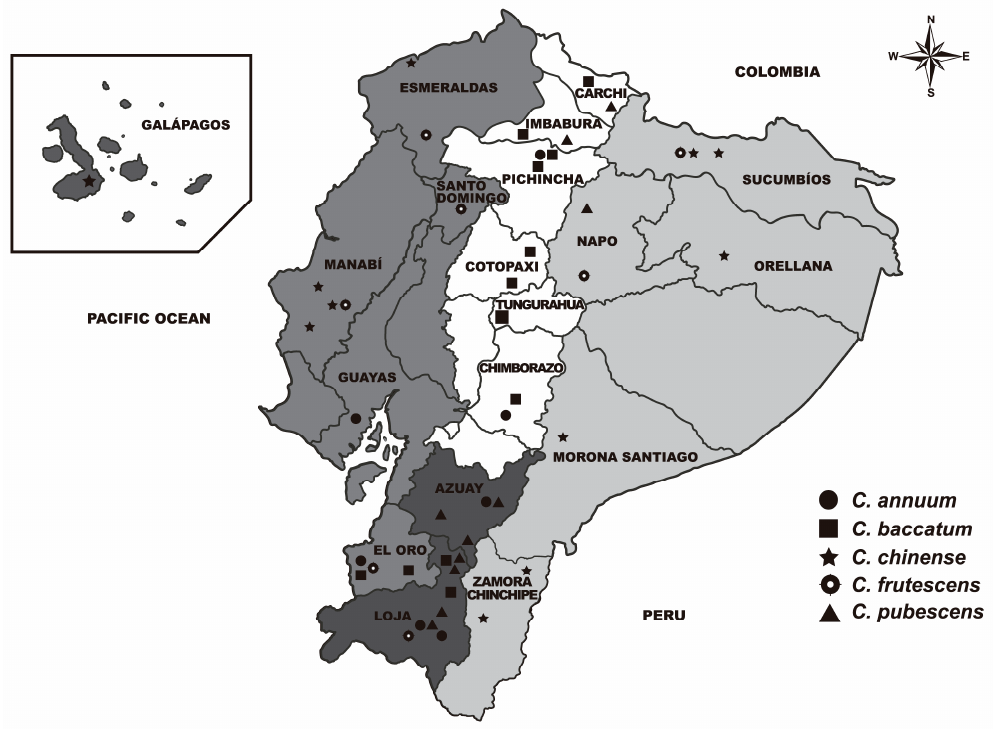
Figure 6. Geographical distribution of Ecuadorian pepper accessions. Provinces colored in white represent the Andes, those in grey the Coast, light grey the Amazon and dark grey the